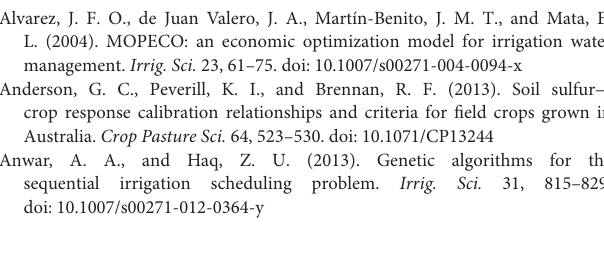
cents per kwhr, which is relatively high and almost equivalent